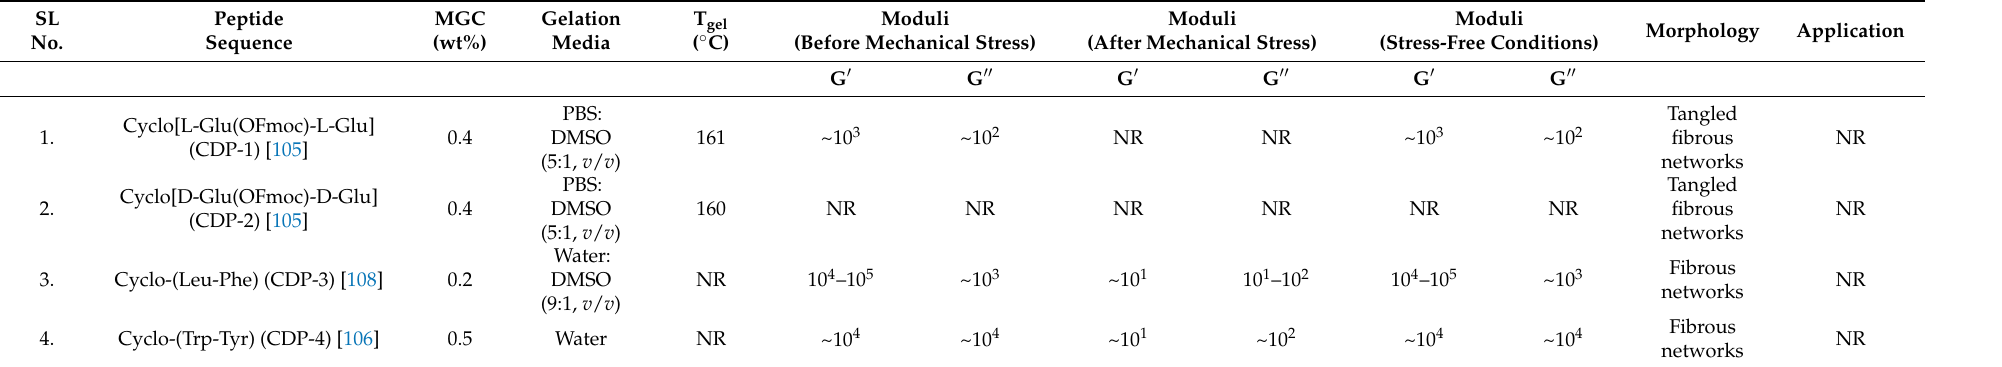
Table 3. List of cyclic dipeptide (CDP)-based thixotropic hydrogelators and respective gelation parameters. SL